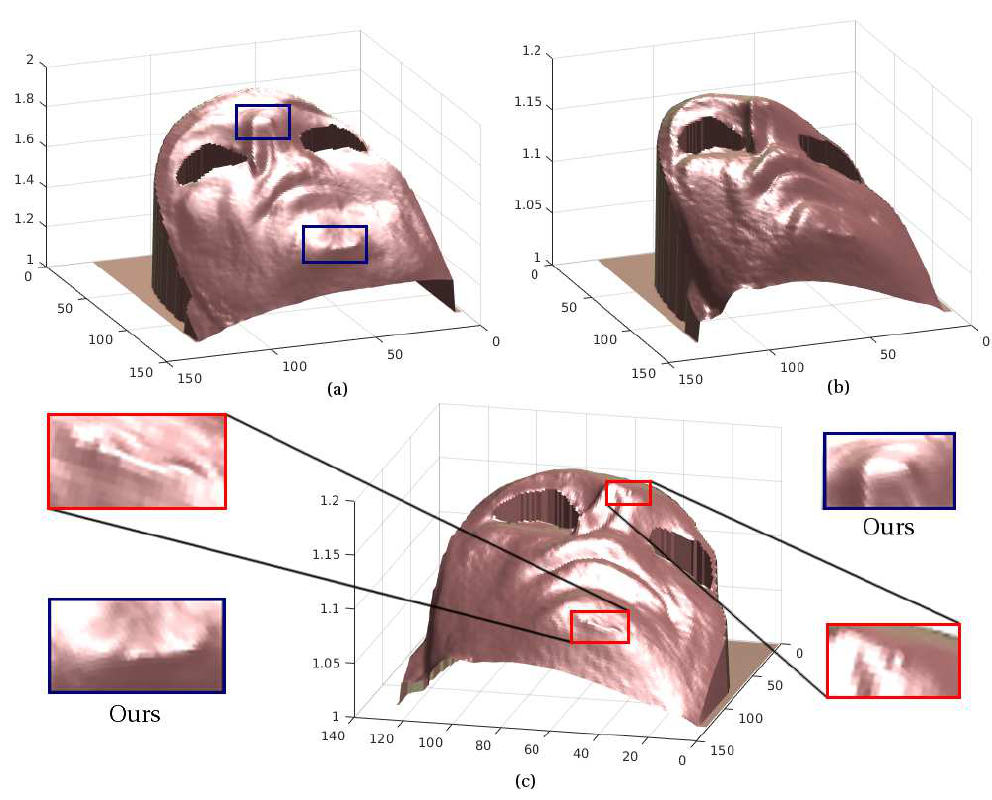
Fig. 16 Depth reconstructions from real world images. (a) Results of our proposed method using the Blinn–Phong model. (b, c) Results using the method of Ref. [30]. Both images are shown from identical viewpoints to visualize the differences. Cropped parts of results from both methods are shown in (c). Our approach shows significant superiority in terms of advantages such as smoothness, reconstruction success in specularities, and absence of deviation from the natural symmetric